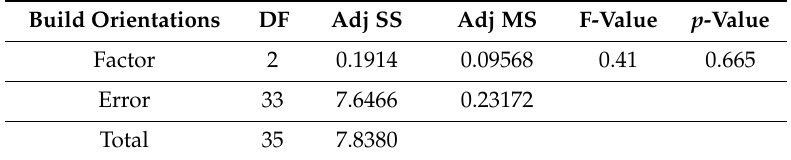
Table 24. ANOVA results for percentage elongation as a function of build